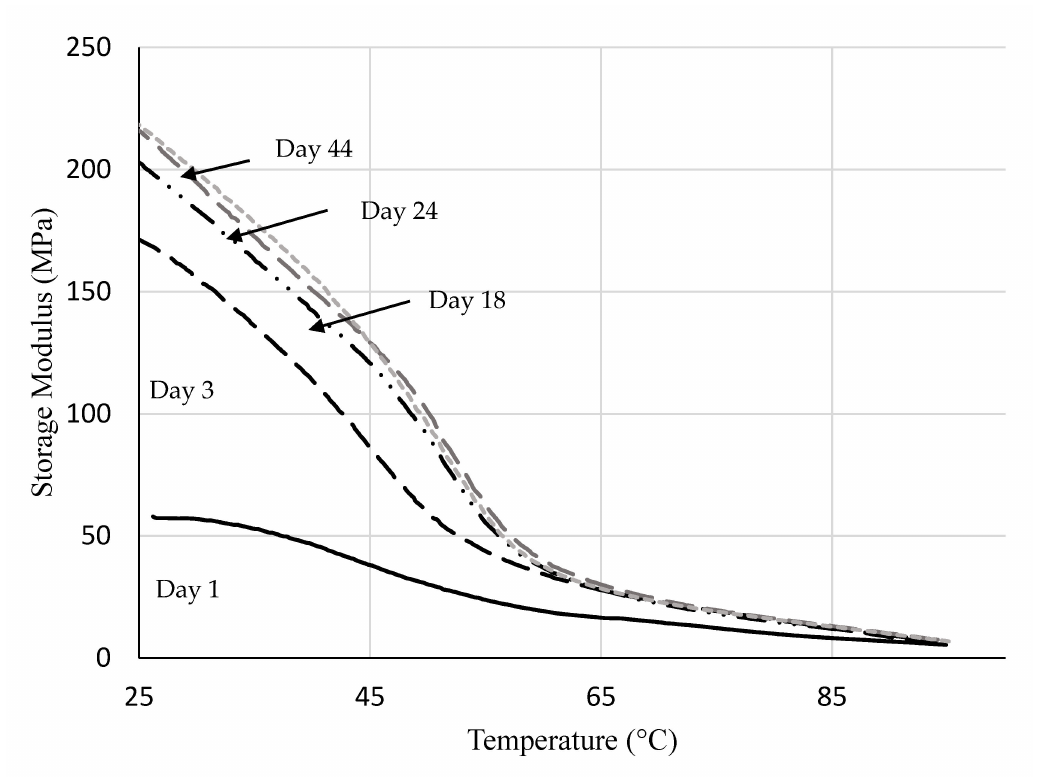
Figure 6. Mechanical aging test of PEMAA-26%Li-122M that shows the effect of aging on the storage modulus of PEMAA using DMA. Days refer to the time between the DMA run and when the sample was injected